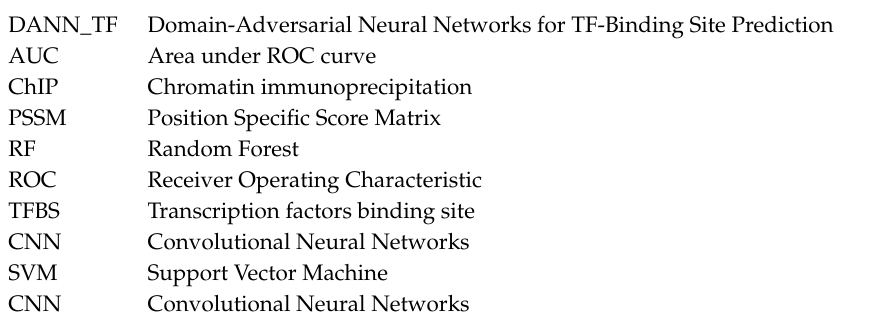
s1. Table S1. The impact of two methods of constructing negative samples on experimental results. Tables S2–S6: Details of AUC and F1 score of data augmentation, semi-supervised prediction with 50%, 20% and 10% labeled training data as well as cross-cell-type prediction by DANN_TF and the baseline method. Tables S7 and S8: Details of AUC and F1 score comparison between data augmentation, semi-supervised, and cross-cell-type prediction by DANN_TF. Table S9: Details of F1 score comparison between DANN_TF and the baseline method for cross-cell-type prediction. Table S10: Details of F1 score comparison between cross-cell-type prediction by DANN_TF and supervised prediction by the baseline method. Table S11: Details of AUC and F1 score of cross-cell-type prediction by DANN_TF and the baseline method and supervised prediction by the baseline method on the additional 13 TFs of the five cell types. Figure S1: The performance of cross-cell-type prediction by DANN_TF and the baseline method and supervised prediction by the baseline method for 13 TFs in the five cell